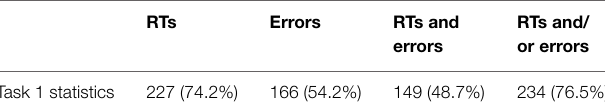
TABLE 2 | Number and percent of experiments (total number experiments is 306) with statistical analyses of (1) RTs, (2) error data, (3) RTs and error data, as well as (4) RTs and/or error data in Task